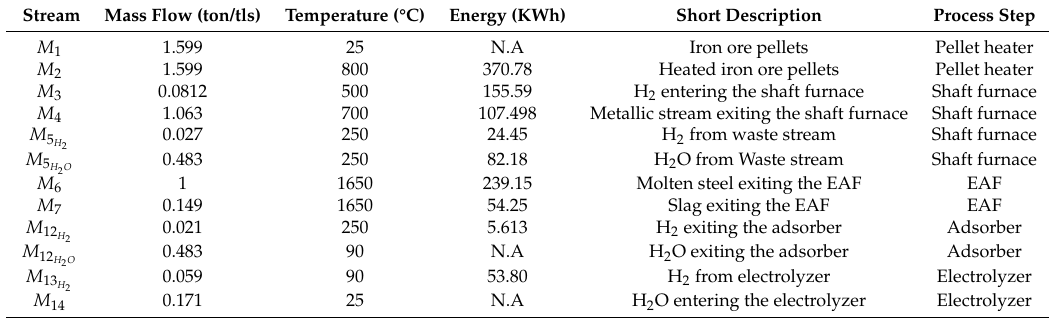
Table 1. Mass and energy flow through the DRI-EAF system. N.A refers to not available or not calculated. Stream Mass Flow (ton/tls) Temperature (°C) Energy